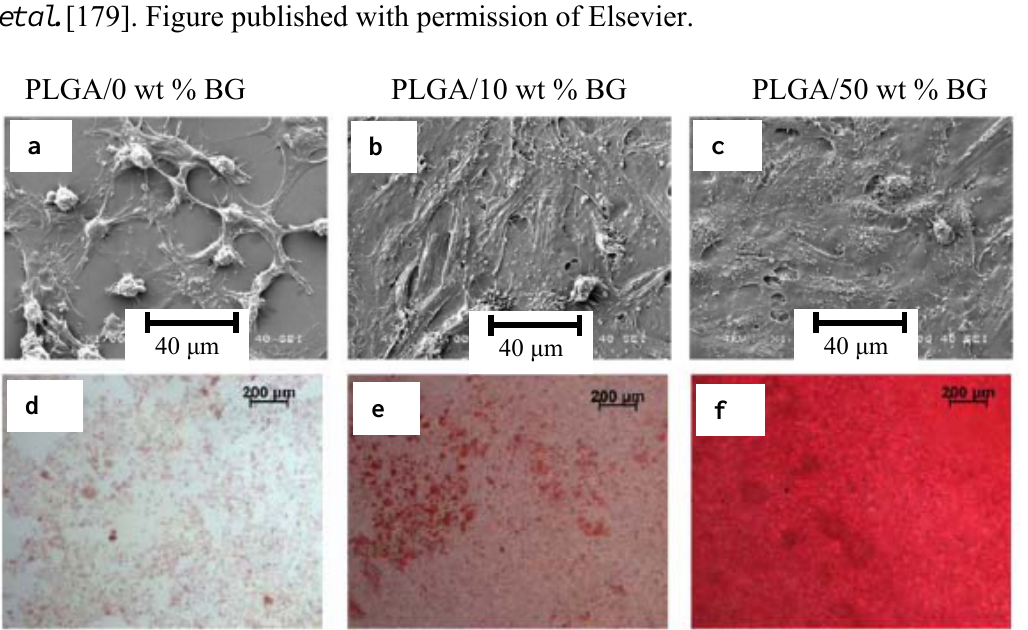
Figure 15. Effect of composition on the growth of osteoblast-like (human osteosarcoma SaOS-2) cells on bioactive glass-PLGA composites (a–c). SEM image in (a) shows lower amount of cells on the pure PLGA surface compared to the two bioactive glass containing composite films (b, c). Alizarin red staining after 28 days in culture (d-f) indicated the positive effect of bioactive glass content on matrix mineralization. The amount of mineralization was significantly higher on the 10 wt % bioactive glass composite (e), likely a combination of cell-mediated mineralization and surface Ca–P formation on the PLGA-bioactive glass composite. Mineralization on sample surfaces: (d) 0 wt %, (e) 10 wt %, (f) 50 wt % bioactive glass containing PLGA composites. Images adapted from Lu et al. [179]. Figure published with permission of